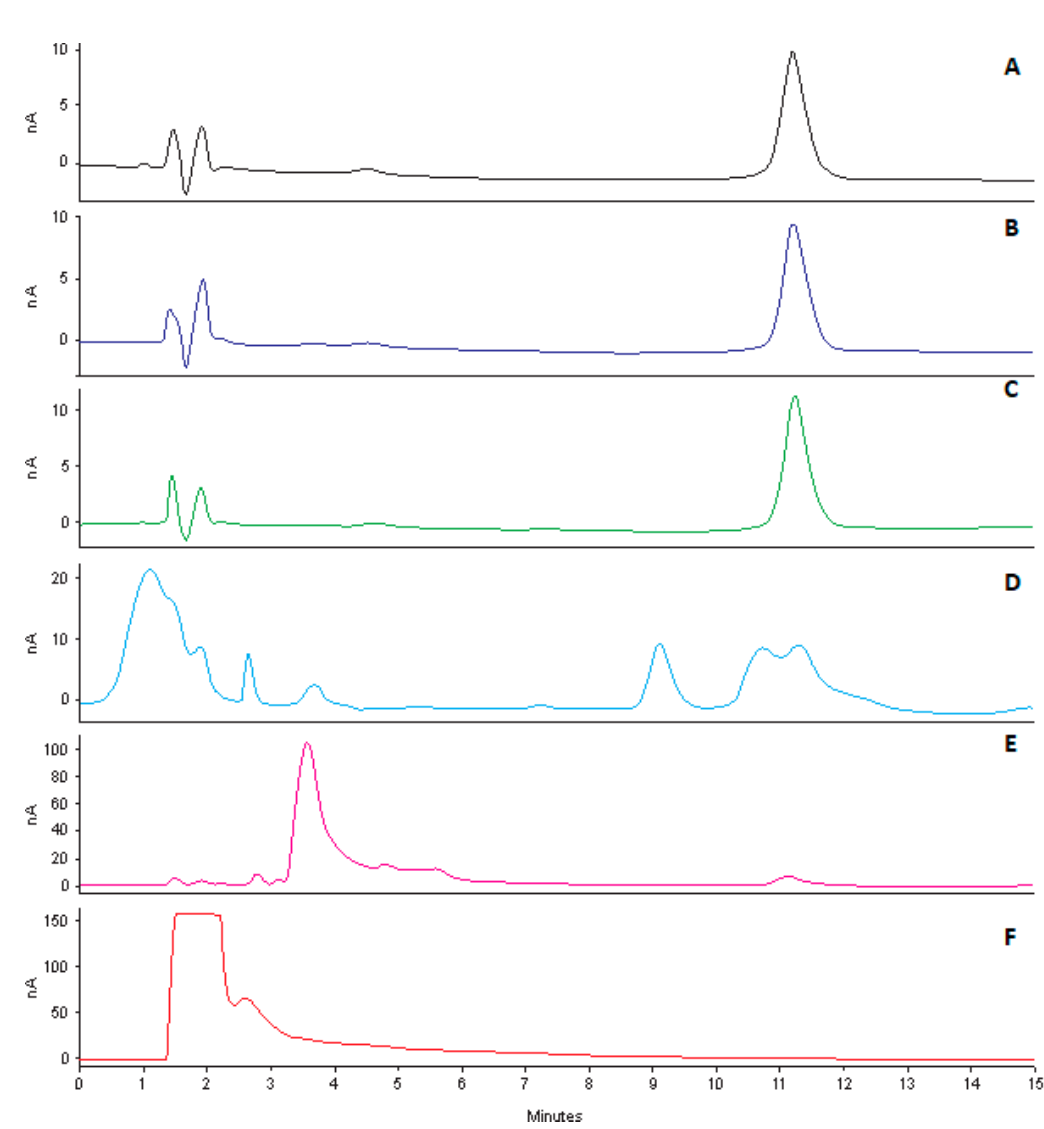
Figure 9. Typical chromatograms following degradation of CLA (10 µg/mL) following exposure to ACN ( A ), heat at 80 °C ( B ), 500 W/m 2 UV radiation ( C ), 0.1M HCl ( D ), 0.1M NaOH ( E ) and 4% v/v H 2 O 2 ( F ).